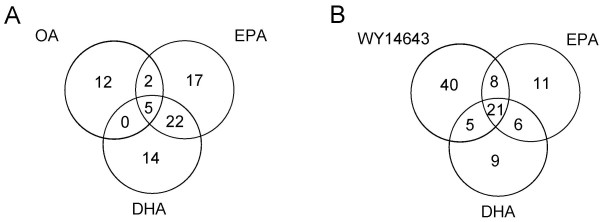
Overlap of PPARα-dependently regulated genes between the four agonists. The numbers in the Venn plots represent the numbers of PPARα-dependently regulated genes for each treatment. A) Overlap between OA, EPA and DHA, B) Overlap between EPA, DHA, and WY14643.